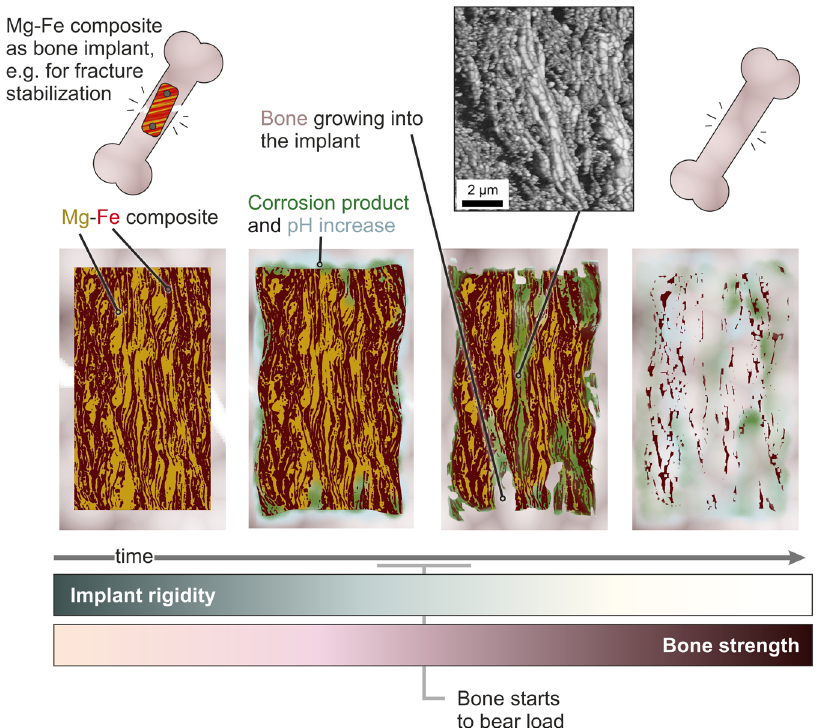
Fig. 5 Schematic of an ideal bone-fracture fi xation, accessible with the developed Mg – Fe nanocomposites. Immediately following the material ’ s implantation, the sur fi cial Mg starts to dissolve, leading to Mg 2 + release and near-surface solution alkalization, as well as formation of voluminous corrosion products, which lead to bulging and exfoliation. With ongoing degradation and formation of larger pores, bone ingrowth is facilitated. New bone replaces the site of the implant within a targeted time of two years. The grayscale image on top represents the Kikuchi pattern contrast from electron backscatter diffraction, showing the remaining Fe skeleton of a partially degraded composite